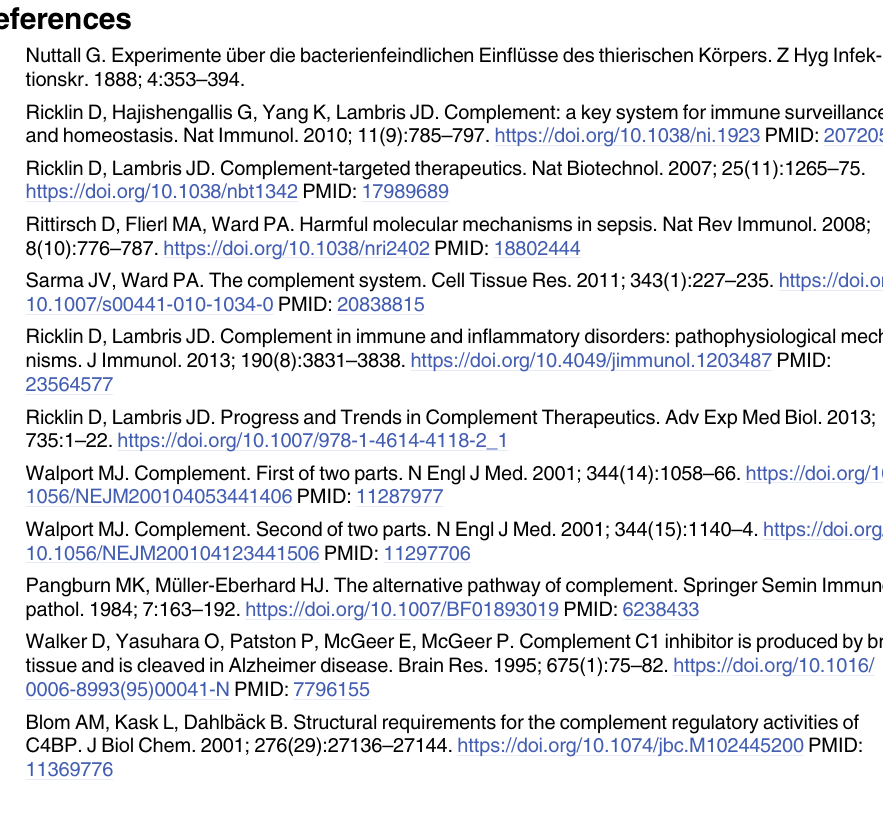
S3 Table. Model species table.